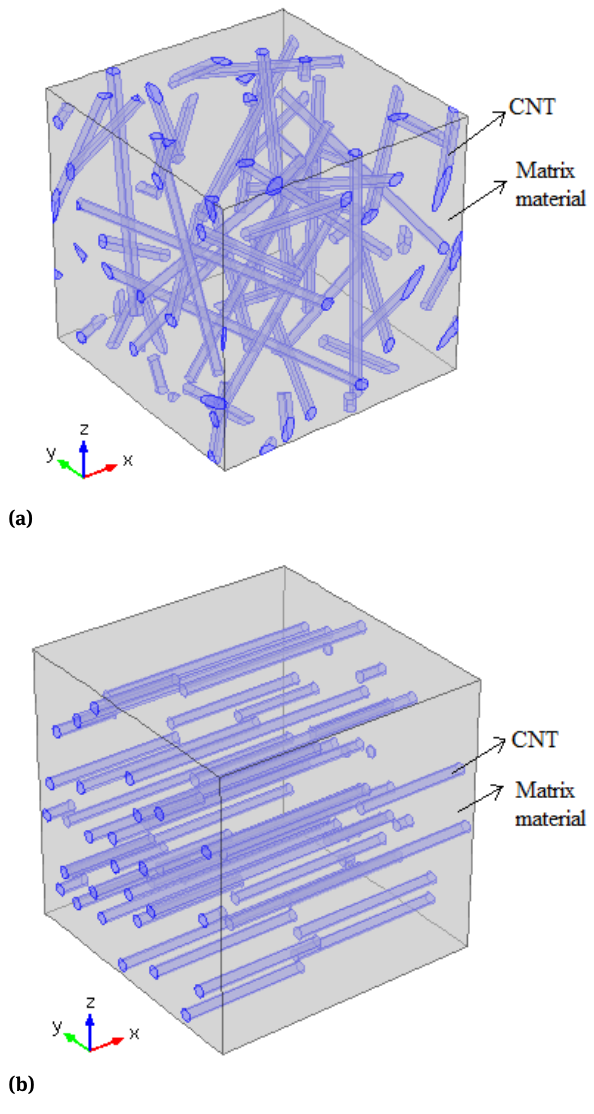
Fig. 5: Periodic RVE containing (a) randomly-oriented and - positioned ESFs (b) aligned and randomly-positioned